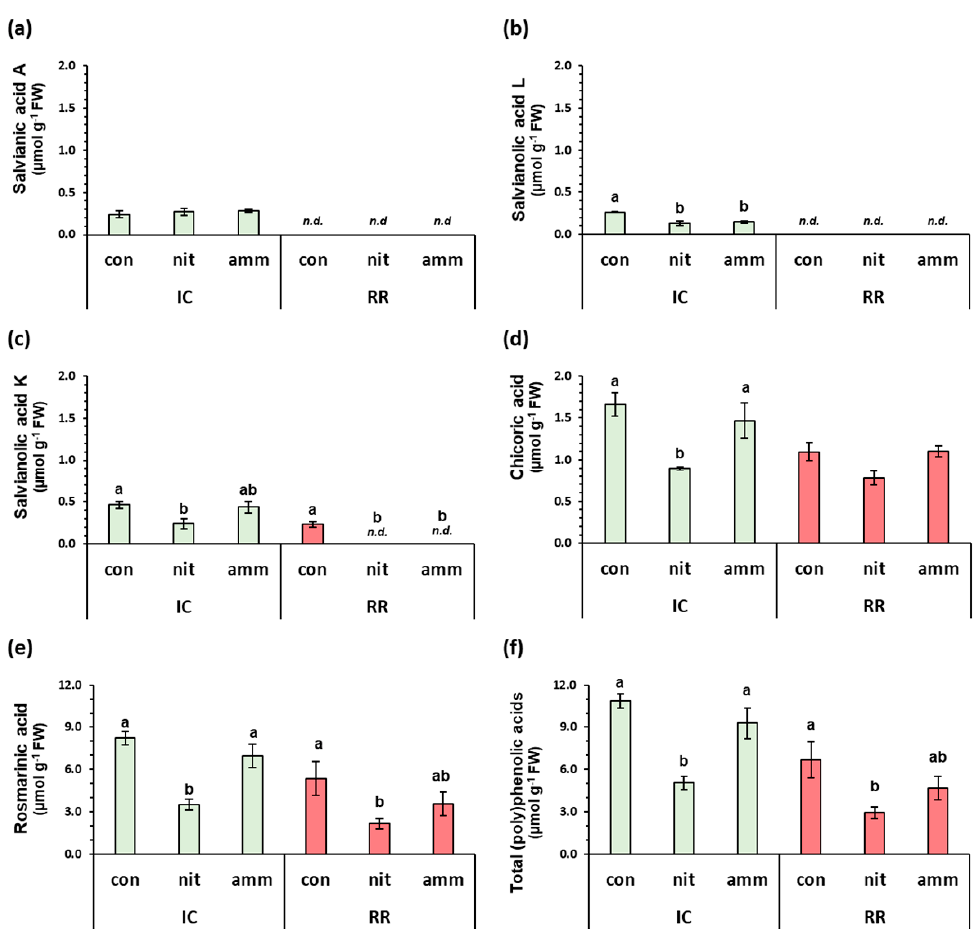
Figure 3. Contents of (poly)phenolic acids in basil leaves in the green ‘Italiano Classico’ (IC, green bars) and in the purple ‘Red Rubin’ (RR, red bars) cultivars. Plants were exposed for 5 d to absence of N—control [con], 10 mM NO 3 − —nitrate [nit], or 10 mM NH 4+ —ammonium [amm]. Contents of: (a)